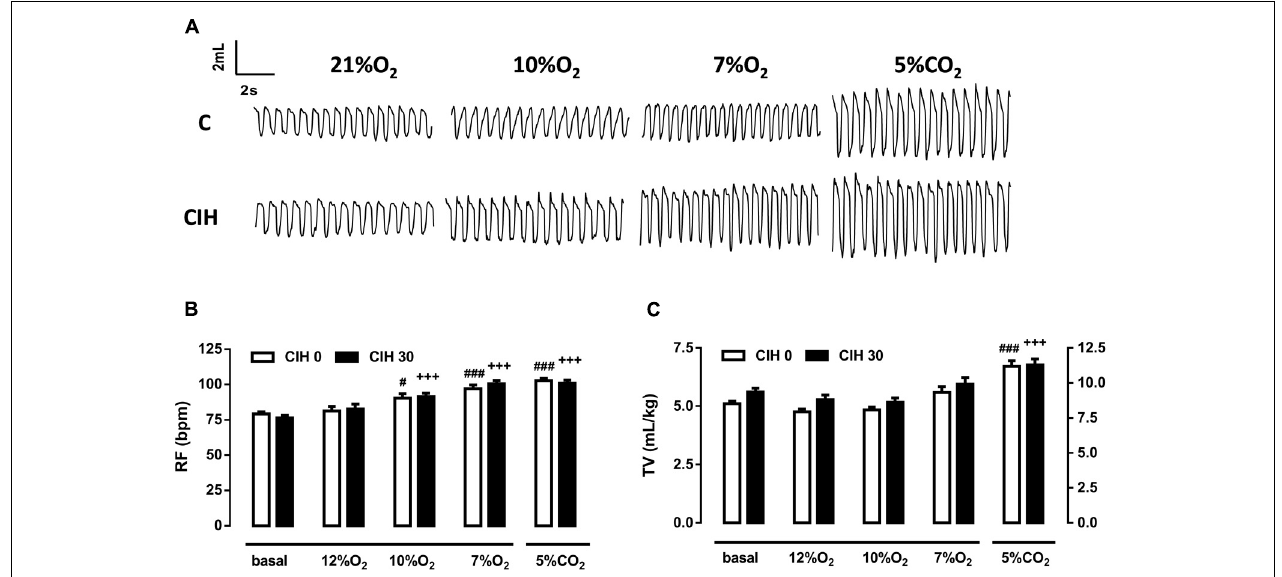
FIGURE 1 | Effect of 30 days of chronic intermittent hypoxia (CIH30) on guinea pig breathing pattern. (A) Sample plethysmography recordings of one control (CIH0) and one CIH30 guinea pig breathing air (21% O 2 ), or 10% O 2 , 7% O 2 and 5% CO 2 acute tests. In (B) , Respiratory frequency (RF) expressed as breaths per minute (bpm) and in (C) , Tidal volume (TV) expressed as mL/kg from CIH0 and CIH30 guinea pigs in response to acute hypoxia (12% O 2 , 10% O 2 , 7% O 2 ) and hypercapnia (5% CO